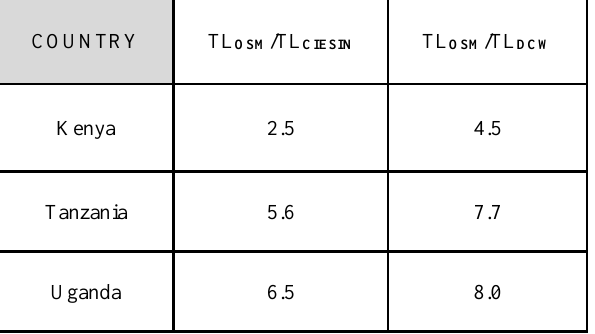
Table 2. Ratio between OSM and DCW road data and OSM and CIESIN road data